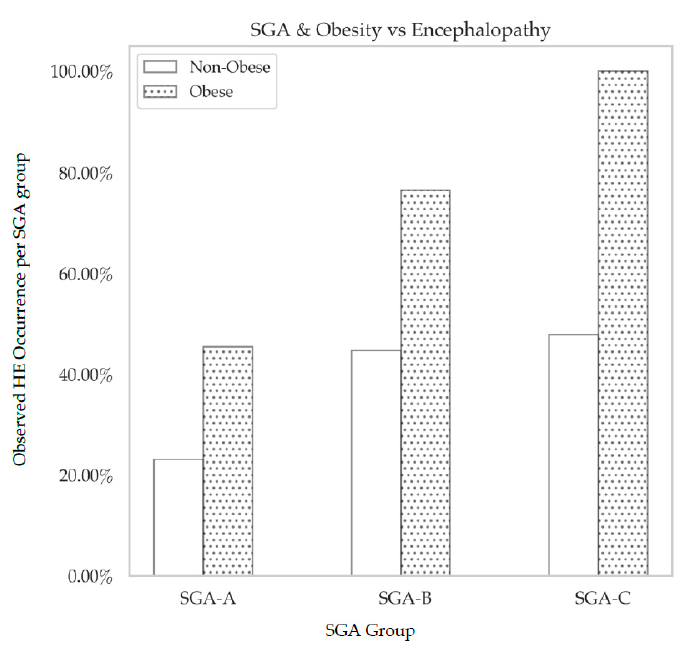
Figure 5. The distribution of HE and obesity across SGA categories. There was an observed trend towards an increased occurrence of HE as a function of muscle wasting, as well as a function of